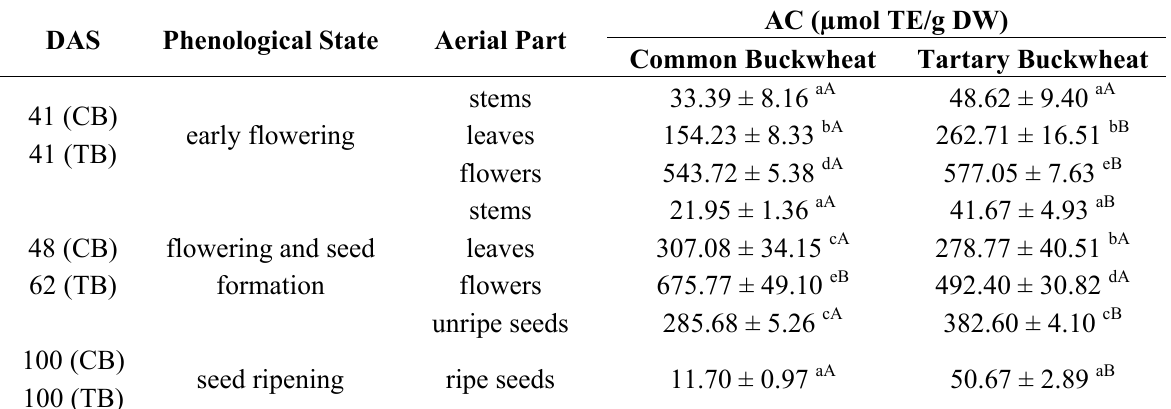
Table 3. Phenological state and antioxidant capacity (AC) of the aerial parts of common (CB) and tartary (TB) buckwheat provided by DPPH assay.